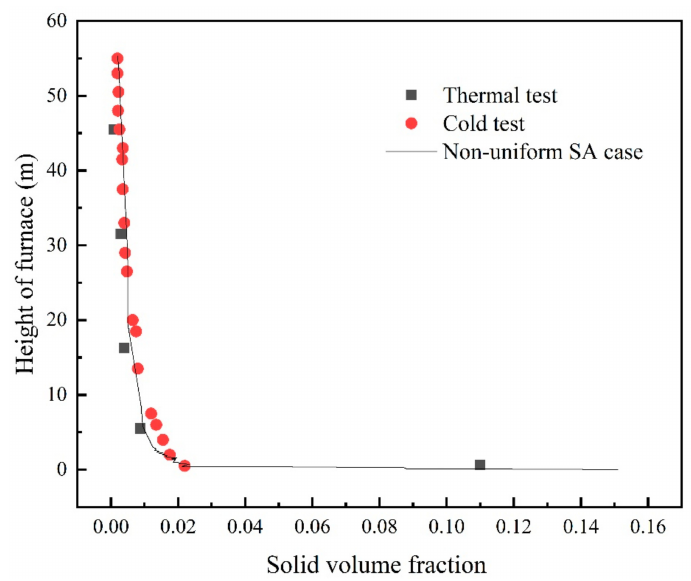
Figure 7. Solid volume fraction along the height of furnace at various